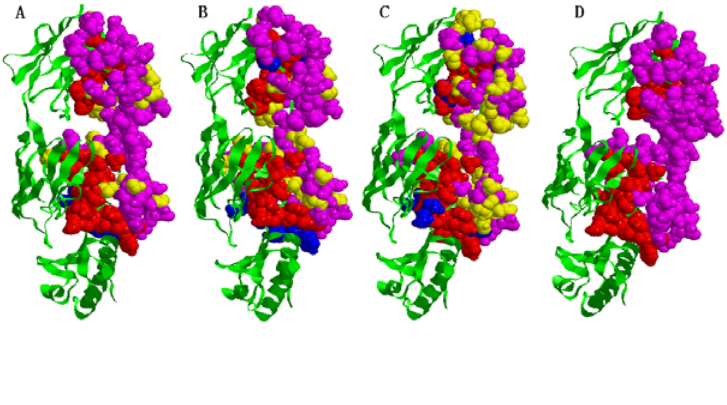
Figure 6. Predicted interface residues (red color) on protein (PDB: 2JEL_H) identified by (A) CA, (B) SVM (C) ME and (D) The actual interface residues. Red denotes true positive residues, blue denotes false negative residues, yellow denotes false positive residues, and pink denotes true negative